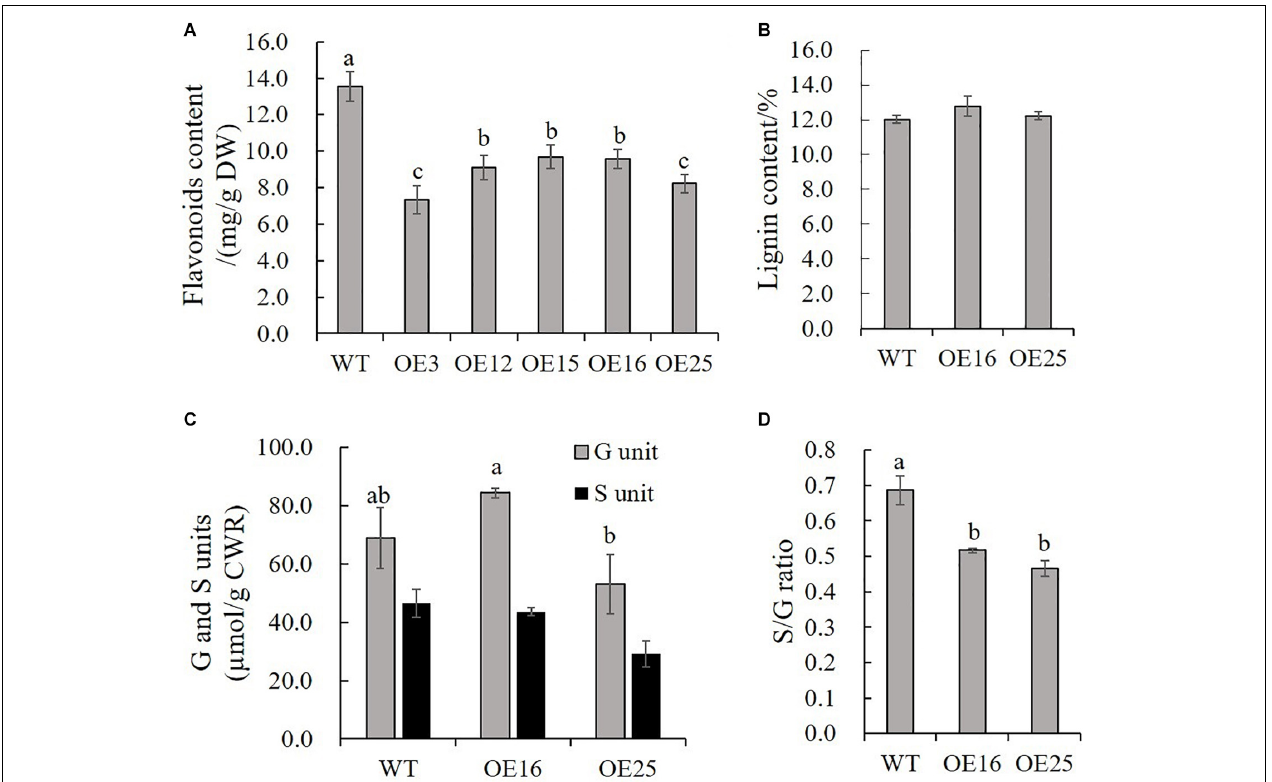
FIGURE 5 | Flavonoids content and lignin content of WT plants and OE-MsASMT1 transgenic plants. (A,B) Total flavonoids content (A) and lignin content (B) in WT plants and OE-MsASMT1 transgenic plants; (C) The lignin monomer G and S unit content in WT plants and OE-MsASMT1 transgenic plants; (D) The S/G ratio in WT plants and OE-MsASMT1 transgenic plants. Data are presented as mean ± SE ( n = 3). The letters indicate the differences between WT and OE-MsASMT1 transgenic plants according to ANOVA analysis ( p <